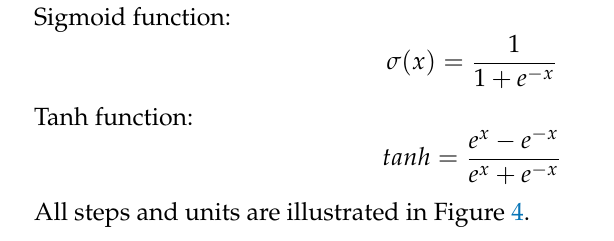
Figure 4. Diagram of a ConvLSTM cell structure from Iskandaryan and others [45].